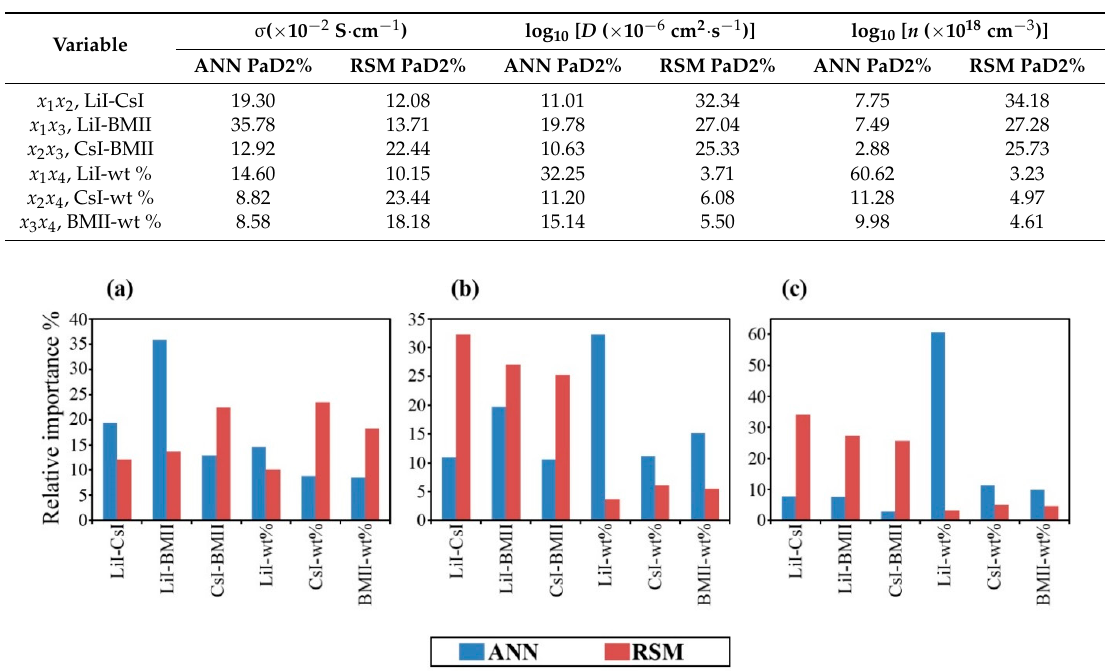
Figure S1. (a) Appearance typical of the GPE prior to adding iodine. Note that the gel is capable of holding the magnetic stirring bit in place without falling to the bottom; and (b) appearance typical of the GPE after adding iodine. Note that the gel appears to be covering the entire length of the vial because the vial was tilted horizontally during stirring after being stirred vertically standing to ensure a more thorough homogeneous mixing; Figure